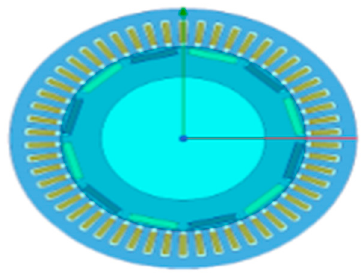
Figure 9. 3D Simulation model of three-phase permanent magnet synchronous generator in